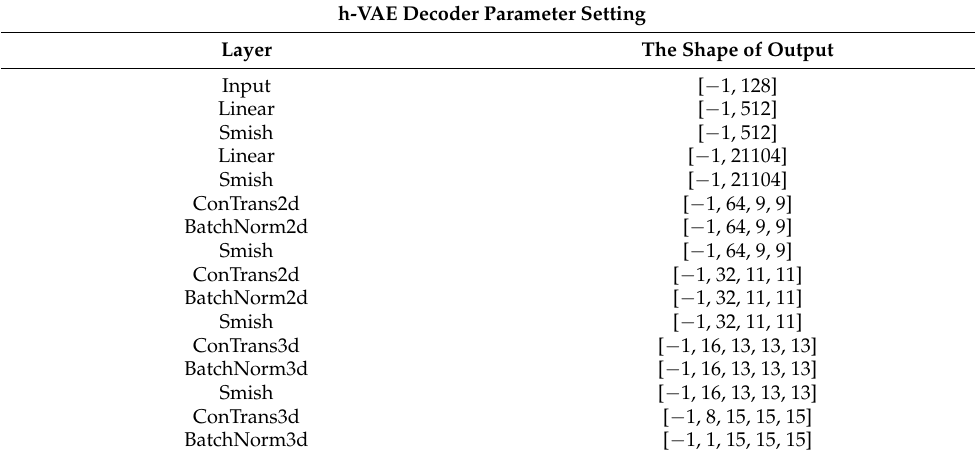
Table 7. The shape of layers in the h-VAE model for decoding.